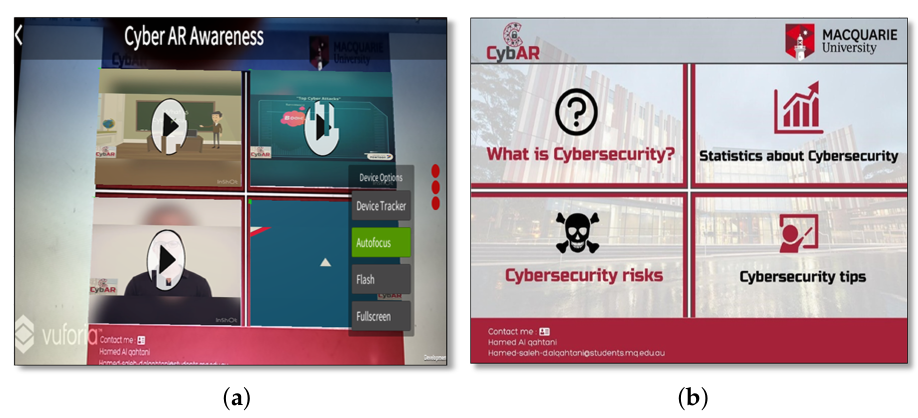
Figure 7. ( a ) CybAR awareness materials. ( b ) CybAR awareness materials marker.